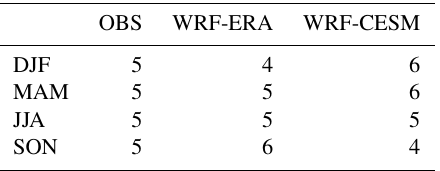
Figure 4. Taylor diagram showing the temporal correlation and ra- tio of standard deviation between the regional series in the WRF- ERA simulation and the observations across all four seasons. For obtaining the regional series, the regions defined for WRF-ERA are used in both datasets. Different symbols denote the result for each season, whereas the colours correspond to the different regions ac- cording to the legend and spatial structure shown in the middle col- umn in Fig. 2. Table 1. Number of regions obtained after the cluster analysis of daily precipitation. The shape of such regions is shown in Fig. 2. The number of EOFs retained is kept to seven in all cases, which corresponds to a explained variance above 80% in all